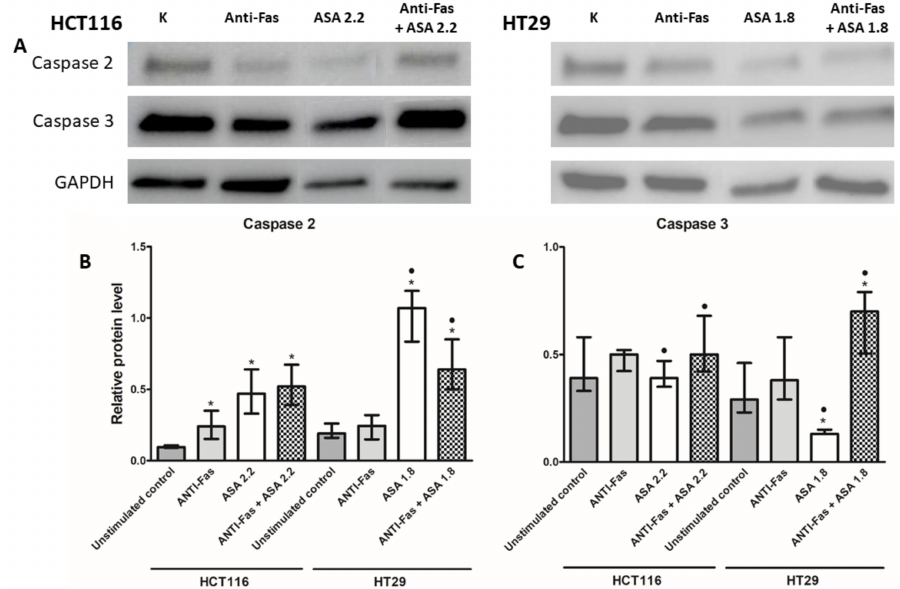
Figure 5. ( A ) Representative western blot analysis images of caspase-2 and caspase-3 proteins in HCT116 and HT29 cells expanded 10 days in spherical forms with agonistic anti-Fas antibody (200 ng/mL) and/or aspirin (ASA) (2.2 mM or 1.8 mM for HCT116 or HT29, respectively). Protein assessment was performed as described in the Materials and methods. Merged image of all proteins as they were analyzed in the same western blot membrane. ( B , C ). Densitometric analysis of the caspase-2 ( B ) and caspase-3 ( C ) expression at the protein level by western blot Bars and whiskers represent median ± interquartile range normalized to GAPDH level in each sample (* p < 0.05 vs. control unstimulated cells, • p < 0.05 ASA vs. ASA/anti-Fas antibody). Statistically significant differences were assessed by Kruskal-Wallis test followed by Dunn’s test as a post hoc procedure. Each experiment was performed in triplicate, except HCT116 caspase-2 analysis which was performed in